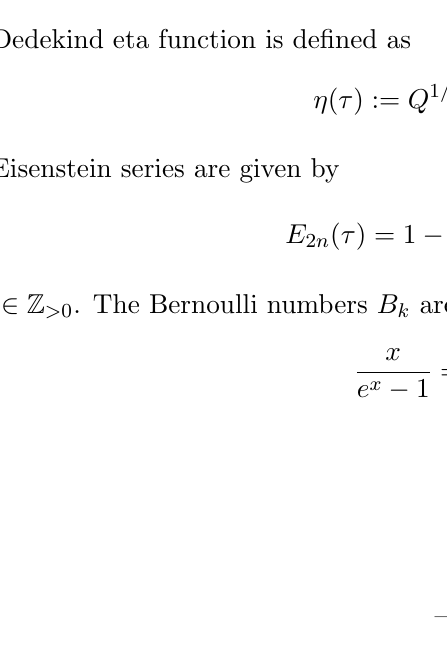
Figure 7 . Feynman diagrams for 4 . There are 17 diagrams: the five hexagonal diagrams on the F top line are 1PI and the others are 1PR. The number under each diagram shows the order of the automorphism group of the graph, which gives the inverse of the symmetry